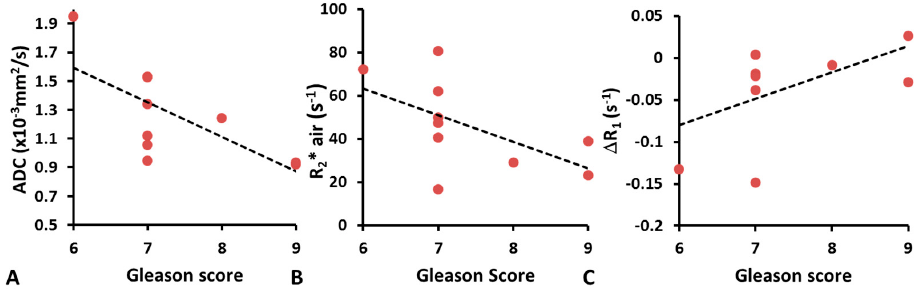
Figure 4. Correlations between Gleason score and multi-parametric MRI. ( A ) Correlation